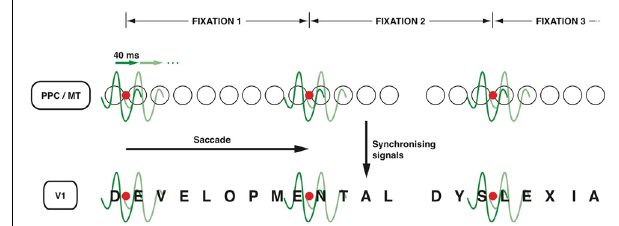
FIGURE 2 | Neuronal oscillations underlying the spotlight of attention that enables sequential letter processing during reading. A wavelet of low gamma frequency (say around 25Hz, i.e., with a period of 40ms) sweeps across the retinotopic map in posterior parietal cortex and MT leading to sequential shift of the locus of top-down facilitation in V1 through interareal synchrony. The letters in the bottom row (DEVELOPMENTAL DYSLEXIA) represent the bottom-up sensory signals in V1 corresponding to each letter of the text that is being read. The fine grain representation of the visual world in V1 preserves the form of each letter, even though they are not coded as “letters” in V1. The circles in the middle row represent the loci of activities in LIP and MT that code for letter locations in the text. The letter representations highlighted by each subsequent cycle of the gamma wavelet are hypothesized to be processed and recognized individually and in sequence in the ventral stream. Only two cycles are shown for each fixation but they are presumed to sweep across the letters away and to the right of the fixation point to cover 7–8 letter-spaces during each fixation. The red dot represents the point of eye fixation. The top row indicates the periods of fixation, each lasting